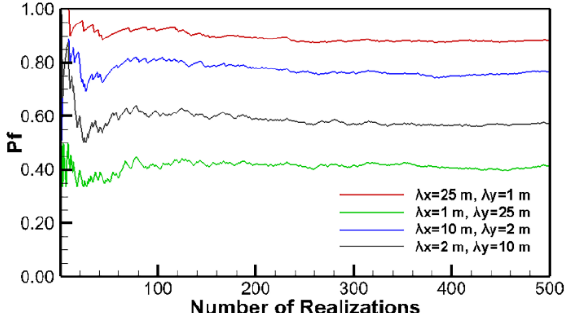
Figure 7. The change in p f with different correlation scales ( Λ = λ x = λ y ).